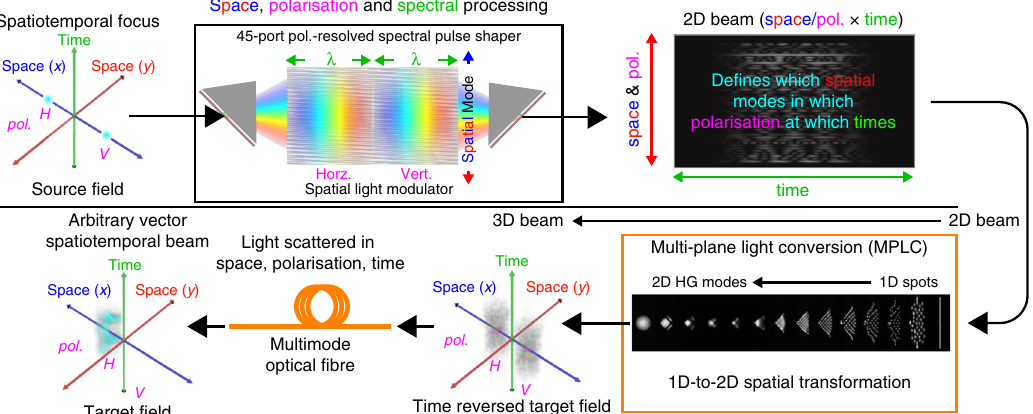
Fig. 1 Simpli fi ed schematic of a device capable of mapping an input vector spatiotemporal fi eld onto an arbitrary vector spatiotemporal output fi eld. Amplitude, phase, spatial mode, polarisation and spectral/temporal degrees of freedom can all be independently addressed simultaneously through the programming of the spatial light modulator. Ninety spatial/polarisation modes can be independently controlled over 4.4 THz at a resolution of ~15 GHz, making a total of ~26,000 spatiospectral modes. Source, time reversed and target fi elds have polarisation components illustrated spatially separated for clarity, but are co-located. Optical system animated in detail in second online video (14:00) in Supplementary Note